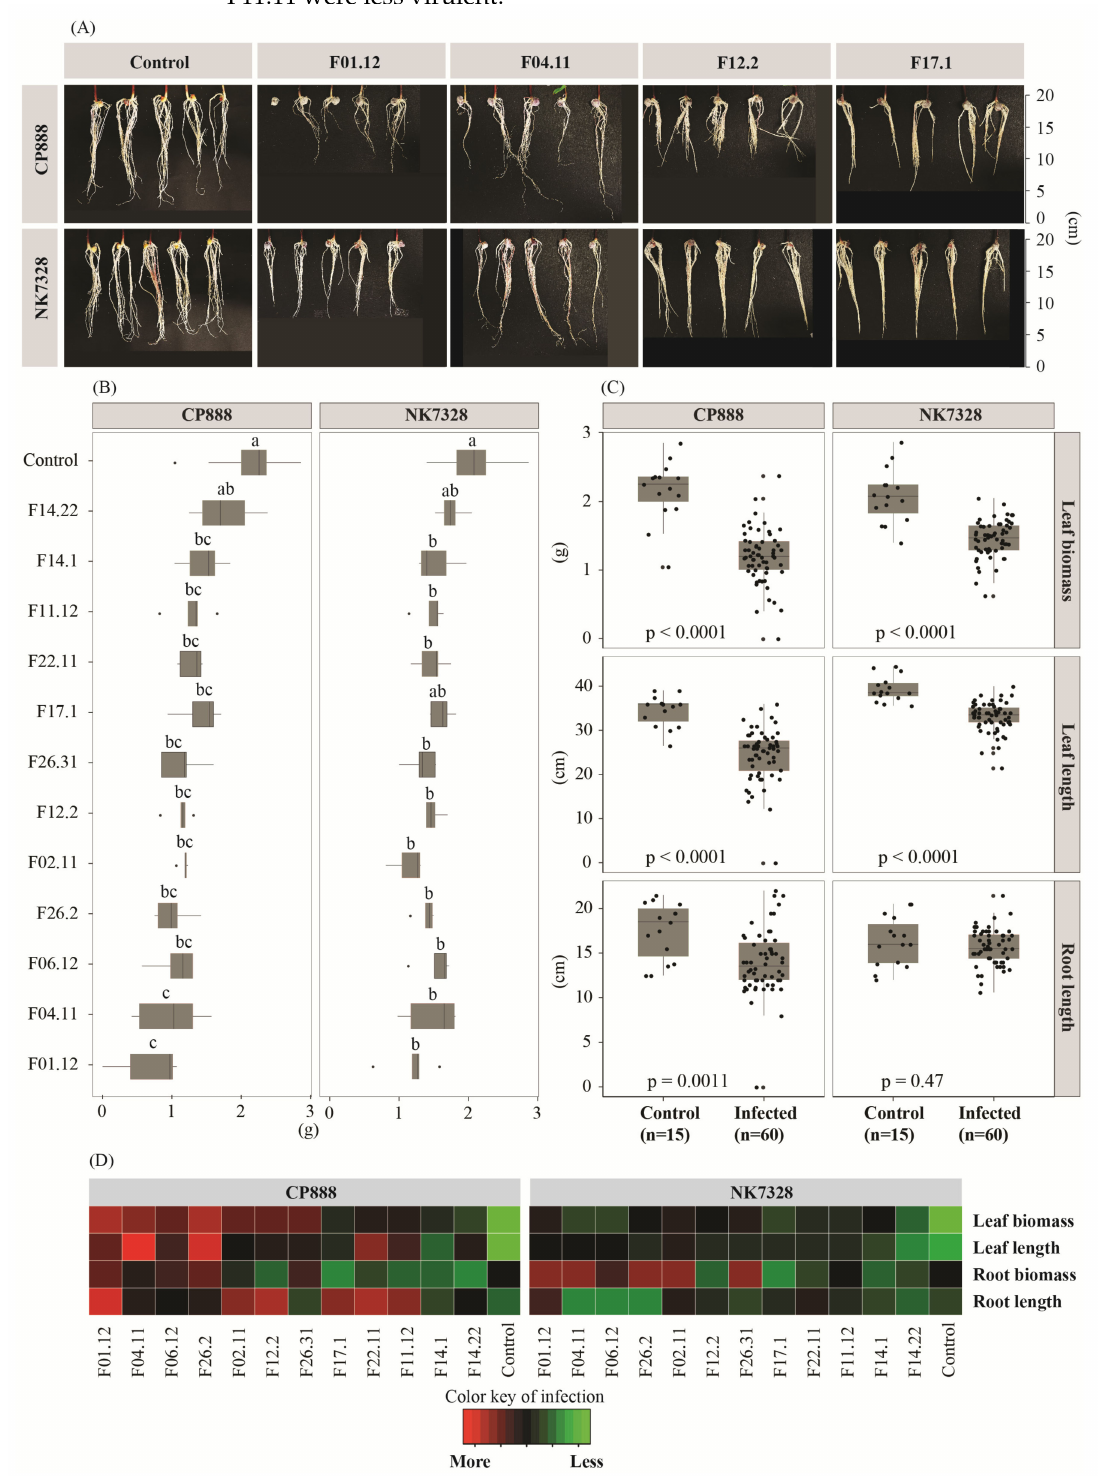
Figure 2. ( A ) Phenotype of roots by treatment upon 14 days. ( B ) Impact on leaf biomass upon infection with each F. verticillioides isolate. Two hybrid maize cultivars CP888 and Bt/GT NK7328 were used. Different letters above each boxplot indicate significant difference within cultivar using a parametric One-way ANOVA test followed by a post-hoc Tukey’s test at a significance level of α = 0.05. ( C ) Impacts on leaf biomass, leaf length and root length. A Student’s t -test was done. ( D ) A heat map of combined growth indicators by isolates. More red is more aggressive to